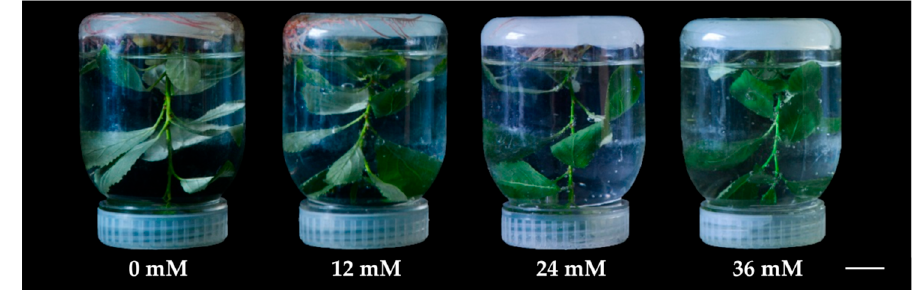
Figure 1. The morphology changes of Populus simonii × Populus nigra under hydrogen peroxide (H 2 O 2 ) stress. The aerial portion of 50-day-old seedling of P. simonii × P. nigra was immersed in 0, 12, 24 and 36 mM H 2 O 2 for 6 h, respectively. Bar = 0.2 cm.